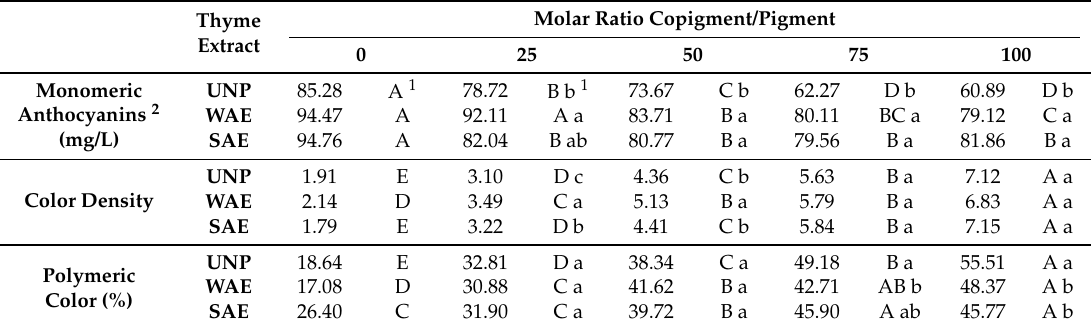
Table 4. Effect of thyme phenolic extracts on the physicochemical properties of strawberry juice systems ( Fragaria anannassa L.). Thyme